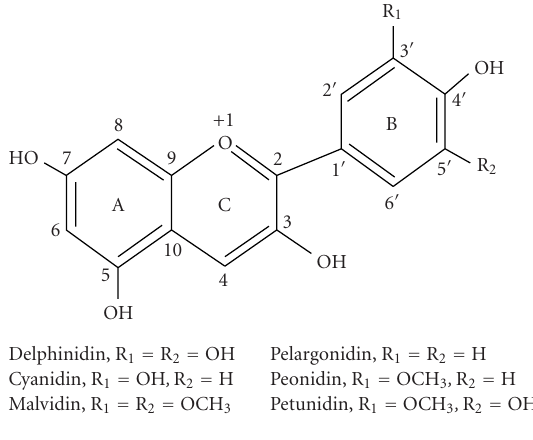
Figure 1. Basic chemical structures of the major anthocyani- dins.